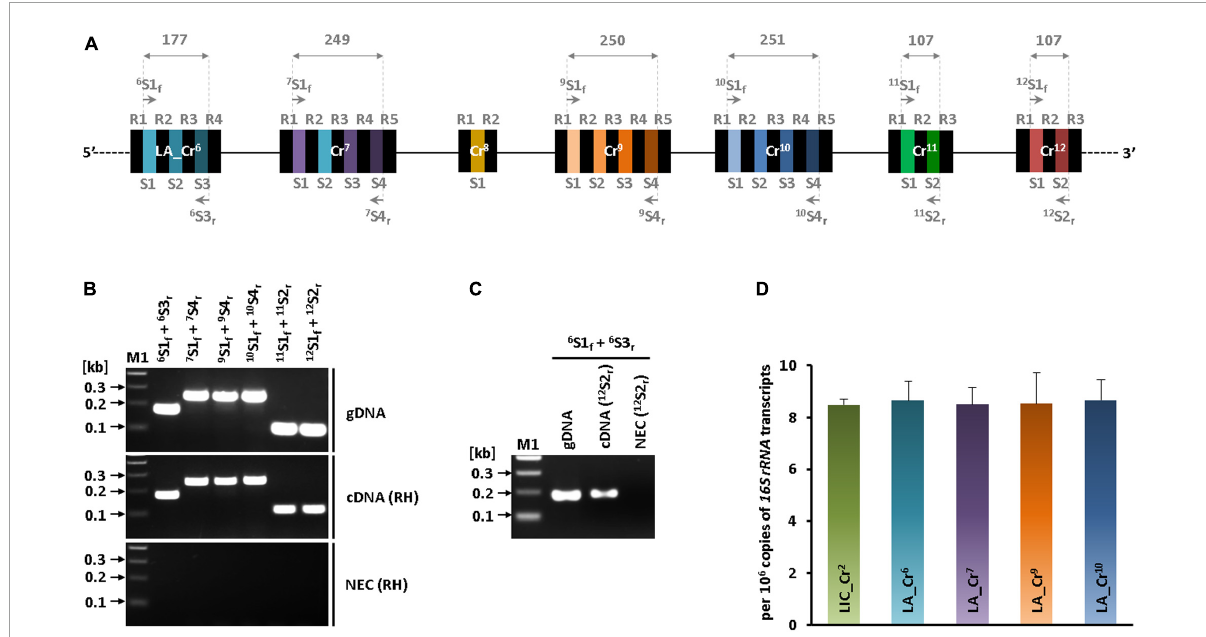
FIGURE3 RT-PCR and qPCR of subtype I-B CRISPRs. (A) Schematic representation of primer pairs position used in the study. Spacer-specific primer pairs used in the RT-PCR experiment are denoted on the hypervariable region (I-B) of serovar Lai. CRISPR regions and length of fragments that were expected to get amplified with primers used in the study are indicated by vertical dashed lines (gray) and numbers (in bp) given at the apex of the double arrowhead over the architecture. (B) Identification of subtype I-B CRISPRs transcription in serovar Lai. PCR using genomic DNA (gDNA; positive control) of serovar Lai with the spacer (first and terminal) specific primer pair of each CRISPR (except LA_Cr 8 ) (top panel). PCR with cDNA template synthesized from total RNA of serovar Lai using random hexamers (middle panel). PCR with RNA (cDNA synthesis reaction without reverse transcriptase) is a no enzyme control (NEC) of the experiment (bottom panel). PCR products were resolved on 2% agarose gel. “M1” denotes the DNA marker used for size estimation of PCR-amplified DNA fragments. (C) RT-PCR of first CRISPR using cDNA prepared using spacer-specific primer of terminal CRISPR of LA_Cr 6 - 12 series. A reverse transcriptase reaction was performed using a terminal spacer-specific reverse primer of LA_Cr 12 . This cDNA template was used in PCR for amplification of LA_Cr 6 . (D) Quantification of transcripts of CRISPR I-B arrays of sv. Copenhageni and Lai. Transcripts of CRISPR arrays (LIC_Cr 2 , LA_Cr 6 , Cr 7 , Cr 9 , and Cr 10 ) are quantified using qRT-PCR per 10 6 copies of 16 S rRNA transcripts of respective Leptospira serovars. Results are indicative of two independent experiments, each performed in